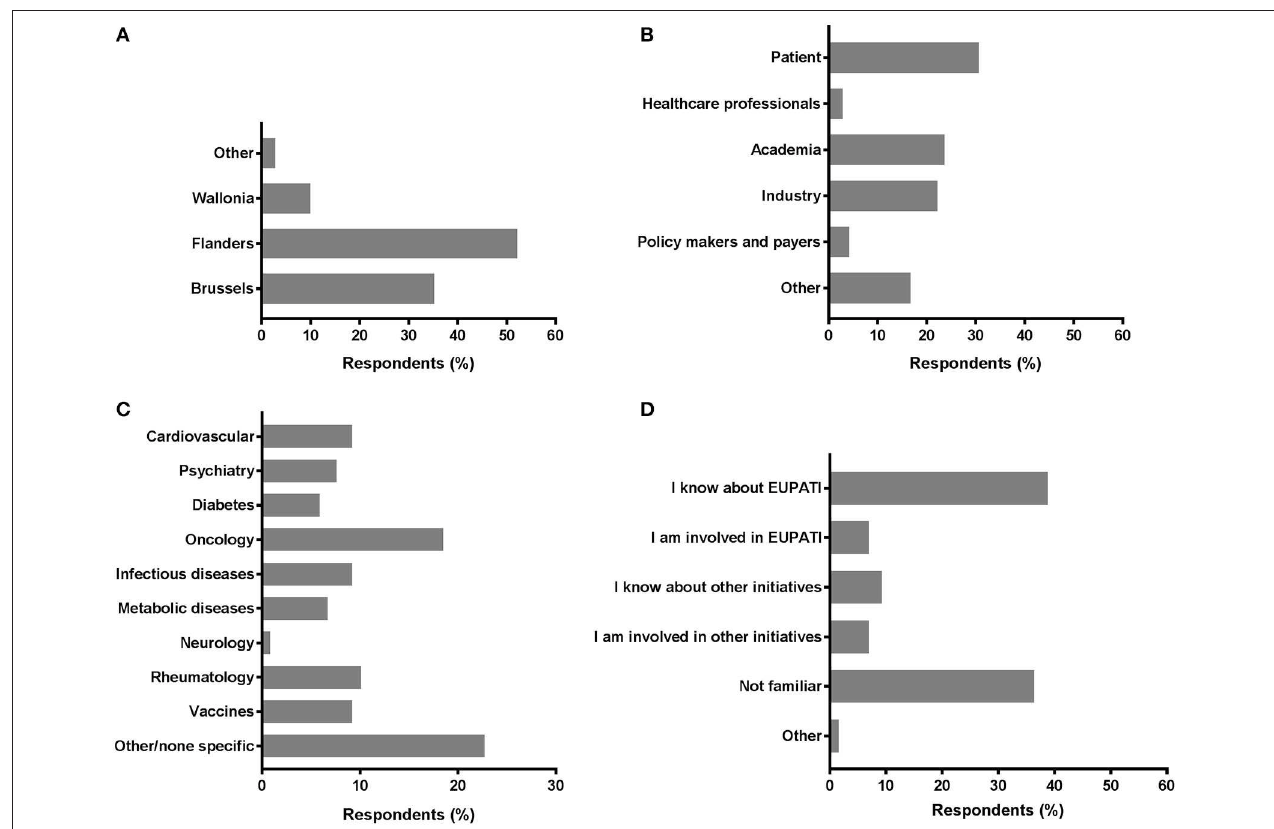
FIGURE 1 | Characteristics of survey respondents. Respondents were inquired into a selection of basic demographics such as (A) region; (B) role; (C) disease field; and (D) familiarity with EUPATI (-like)